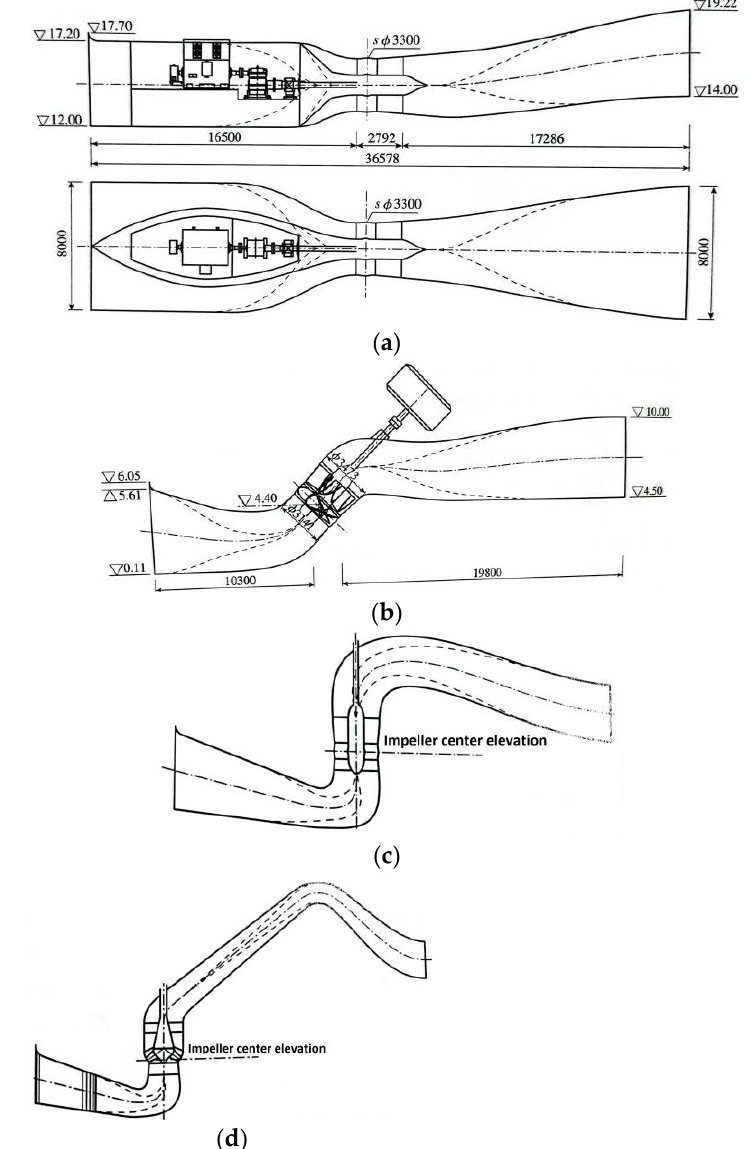
Figure 2. Shaft extension pump device [8]. ( a ) Front-positioned-shaft tubular pump device; ( b ) 45 ◦ - inclined shaft extension pump device; ( c ) vertical axial – flow pump with elbow inlet and low-hump outlet; ( d ) guide vane mixed flow pump device with elbow inlet conduit and siphon outlet conduit.